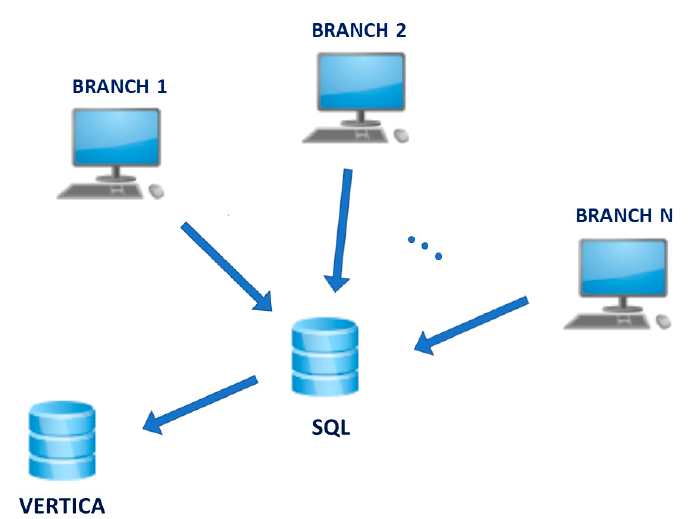
Figure 3. Data Warehouse Architecture.